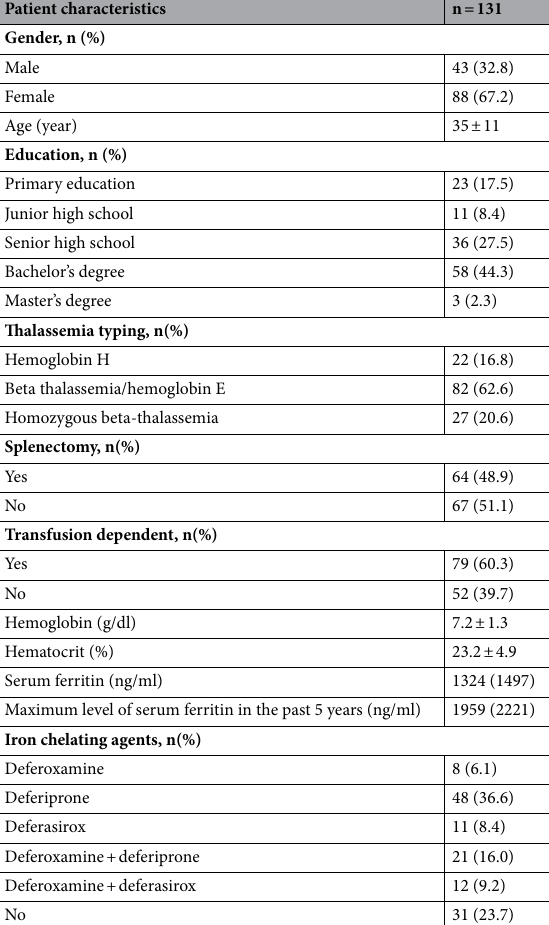
Table 1. Demographic data of thalassemia patients. Data from age, hemoglobin, hematocrit, and MoCA score were represented by mean ± SD, while data from serum ferritin and Maximum level of serum ferritin in the past 5 years were represented as median and IQR. MoCA montreal cognitive